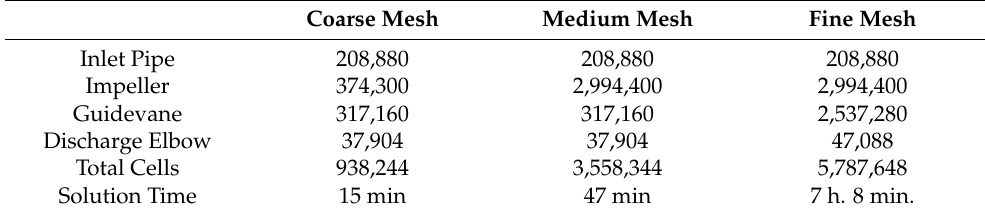
Table 2. The cell count for each region and simulation